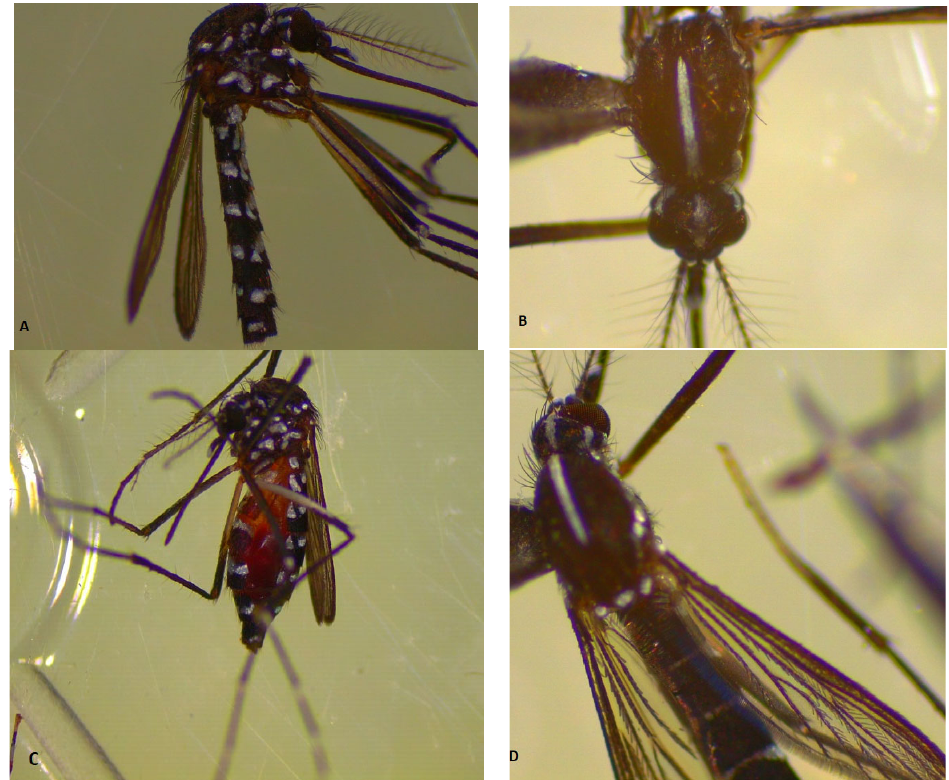
Figure 3. Ae. albopictus : ( A ) Unfed female, ( B ) specific morphological feature of the thorax, ( C ) fed female, ( D ) specific morphological characters: Head, thorax, and abdomen.